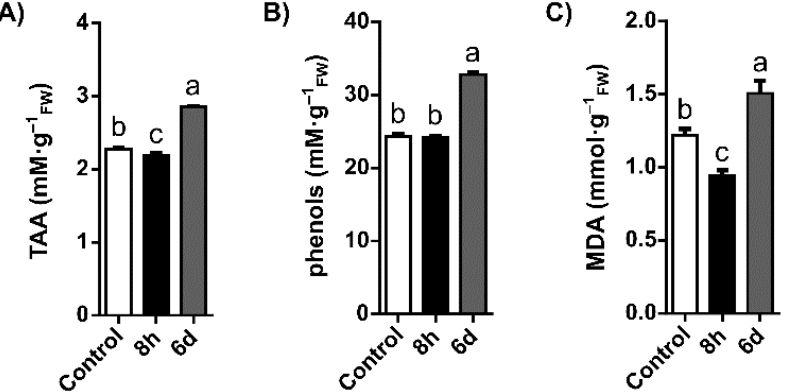
Figure 1. Root total antioxidant activity ( A ), total phenol content ( B ), and malondialdehyde level ( C ) in Q. suber roots under control and salinity conditions (8 h and 6 days after 300 mM NaCl treatment). White bars: control; black bars: 8 h; grey bars: 6 days. Values are mean ± SEM (n = 6). Letters indicate significant differences between groups ( p < 0.05).